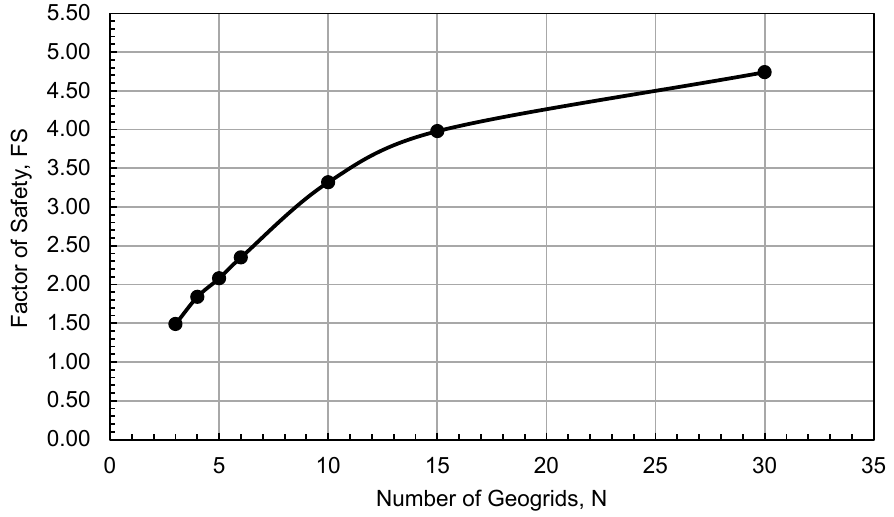
Figure 10 and Table 7 present the FS values obtained with different geogrid numbers.